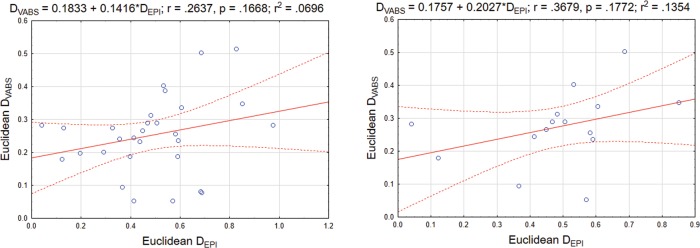
Scatterplot graphs depicting the associations between the index of the deviation (from the averaged profile of children in the BFC group) of the VABS behavior profiles (DVABS; y-axis) and DNA methylation profiles (DEPI; x-axis) in the group of IC children.Two graphs are presented: data from the total sample of IC children (N = 29; left plot) and for the subgroup of children who have been placed into institutional care after birth (N = 15; right plot).